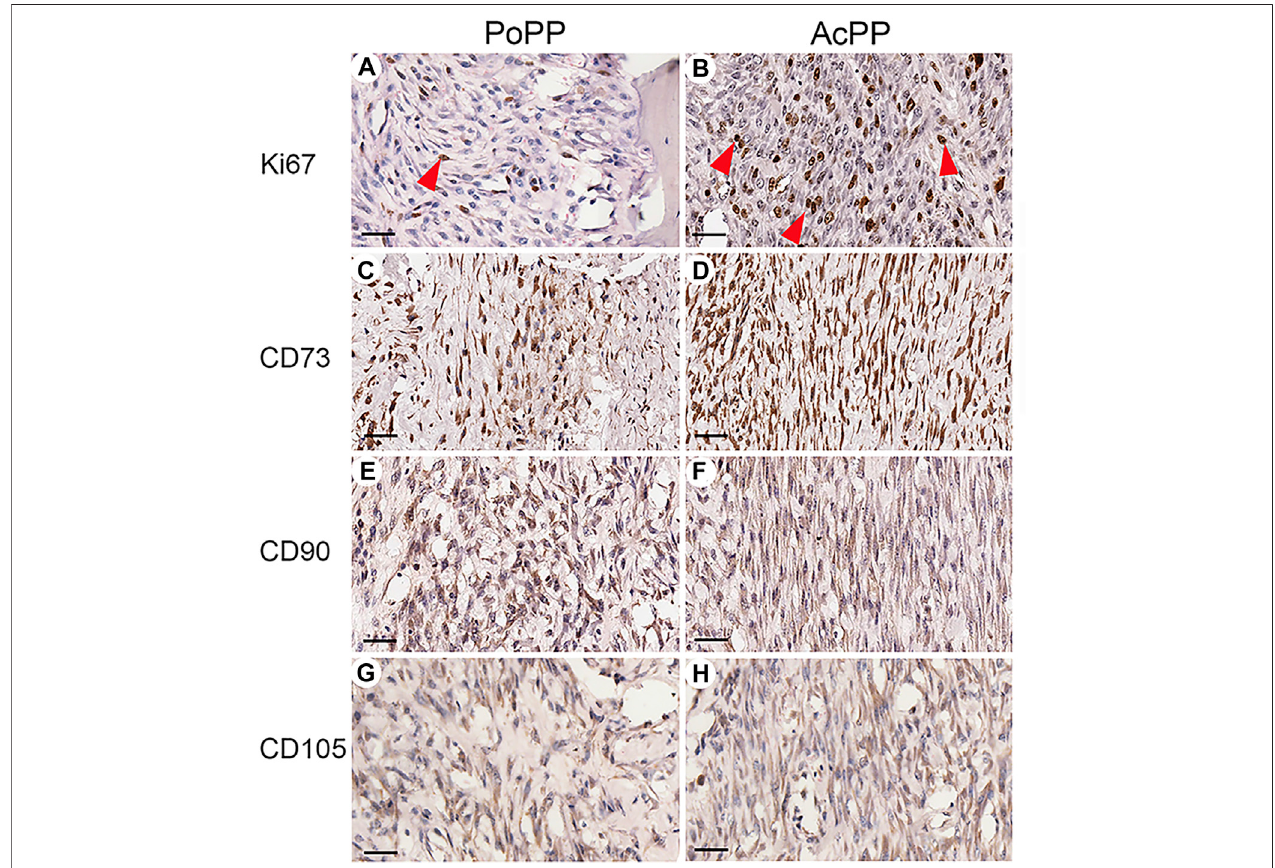
FIGURE 2 | Immunohistochemistry (IHC) of Ki67 and MSC marker genes for the PoPP and AcPP. PoPP: (A,C,E,G) ; AcPP: (B,D,F,H) , (A,B) IHC staining of Ki67 (red arrowheads). (C,D) IHC staining of CD73. (E,F) IHC staining of CD90. and (G,H) IHC staining of CD105. Scale bar = 50 µm.